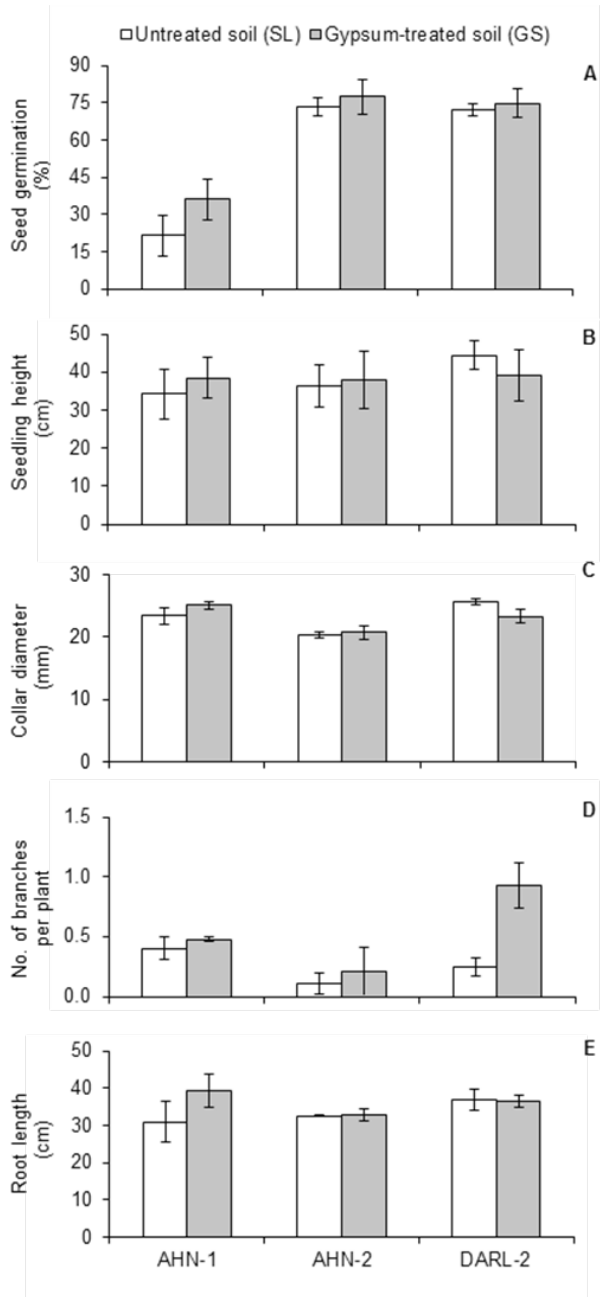
Fig. 1. Seed germination (A); seedling height (B); collar diam- eter (C); Number of branches/plant (D) and root length (E) of 120-days-old seedlings of elite strain (DARL-2) and local strains (AHN-1 and AHN-2) of J. curcas grown on untreated and gyp- sum-treated soil. Vertical bars represent ± S.E. of